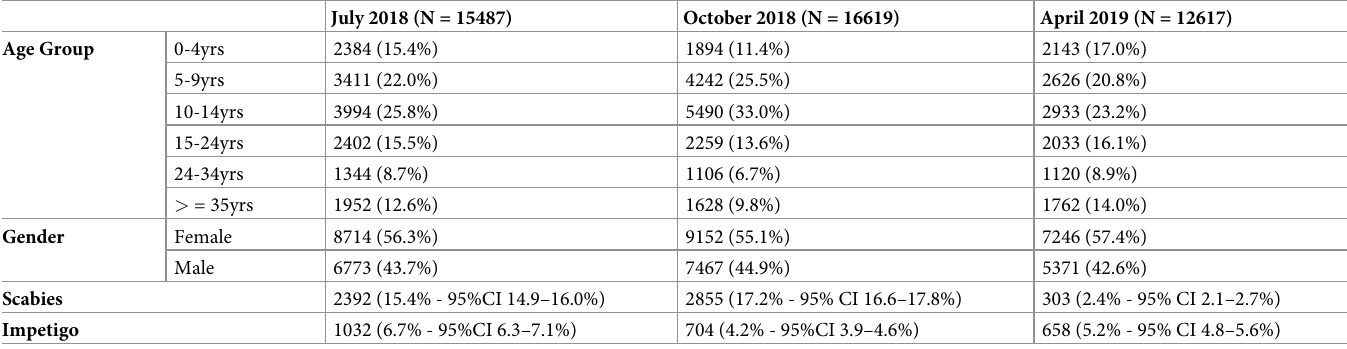
Table 2. Individuals seen during community based